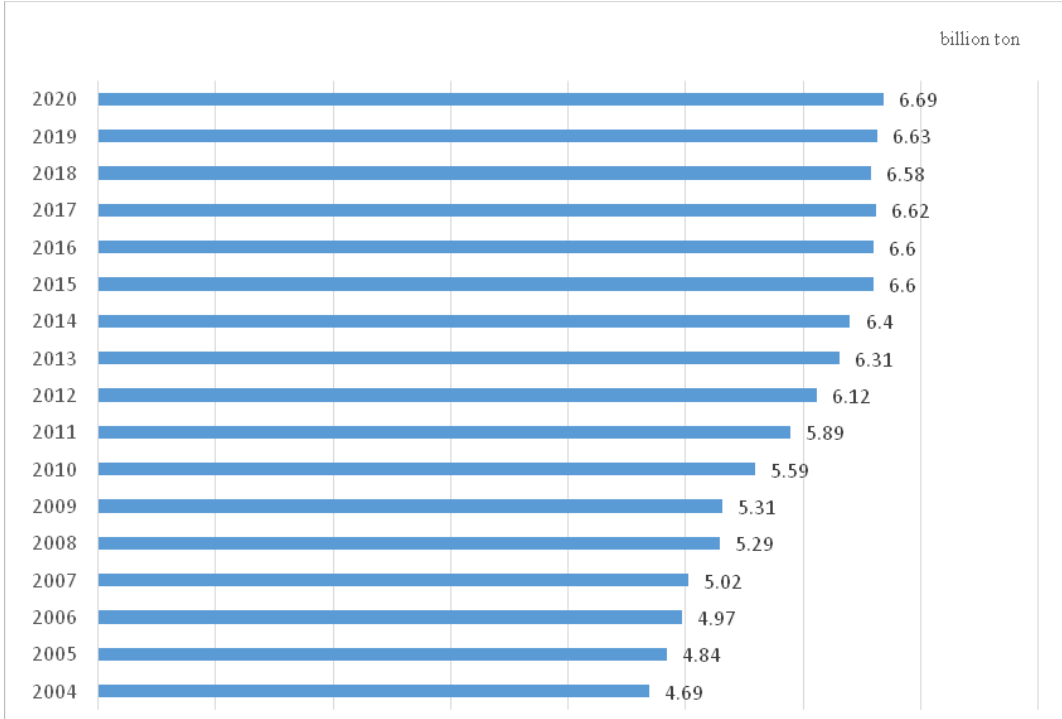
Figure 1. Annual grain output in China (2004–2020). Data Source: National Statistics